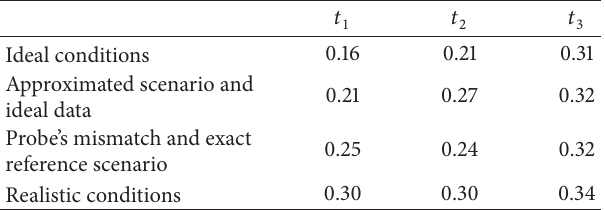
Table 1: RMS error in the region of